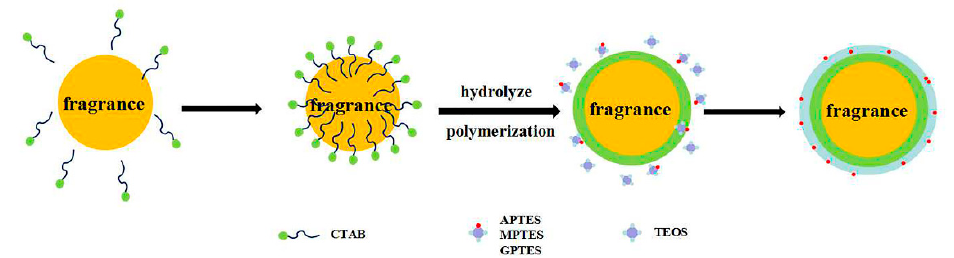
Figure 1. Schematic diagram of the reaction steps of organically modified silica (ORMOSIL) rose fragrance nanospheres.